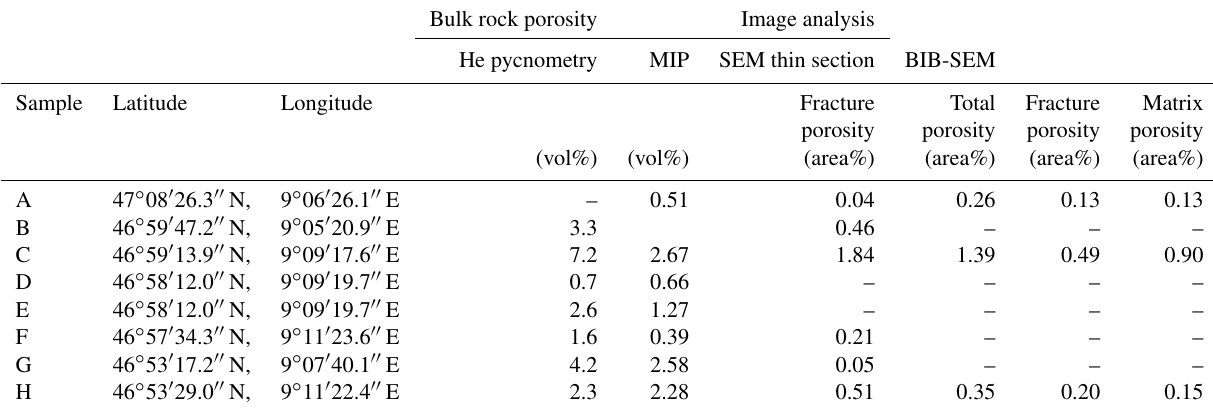
Figure 9. Microstructure and microstructural porosity imaged with BIB-SEM along the temperature gradient. (a, b) Low-temperature sample A shows the smallest porosity, mainly present as intra-particle pores in quartz and dolomite. (c, d) Intermediate temperature sample C shows microcracks along sheet silicates and inter-particle pores as an effect of dissolution. (e, f) High-temperature sample H with a defined spaced cleavage shows more microcracks than the intermediate sample C. OM: organic matter; Qz: quartz; Py: pyrite; Fsp: feldspar; Cal: calcite; S0: bedding. Table 1. Samples, coordinates and porosity estimates from each of the different measurement